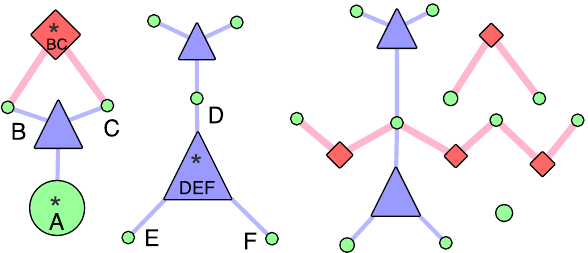
Figure 6. The example plot of the top five variables in 1-SNV, 2-SNV and 3-SNV